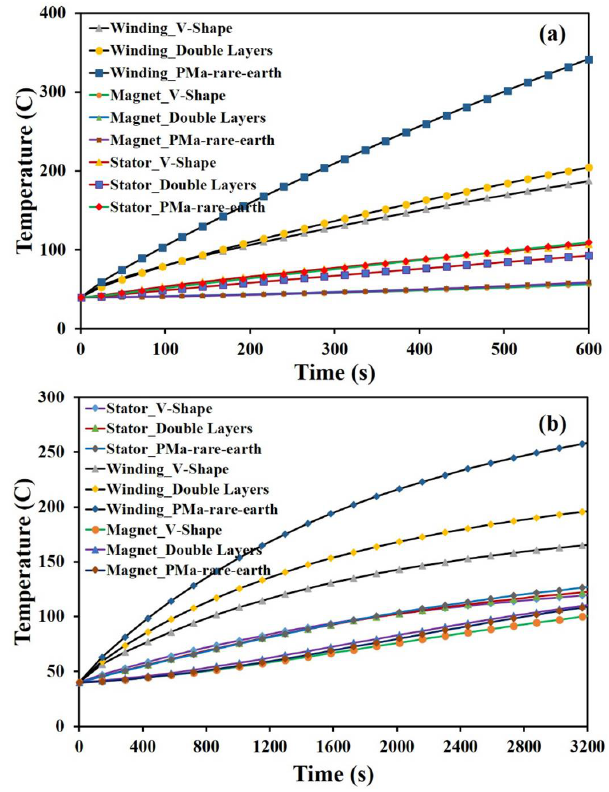
Figure 19. The temperature rise for winding and magnet: ( a ) peak; and, ( b ) rated/continuous operations.